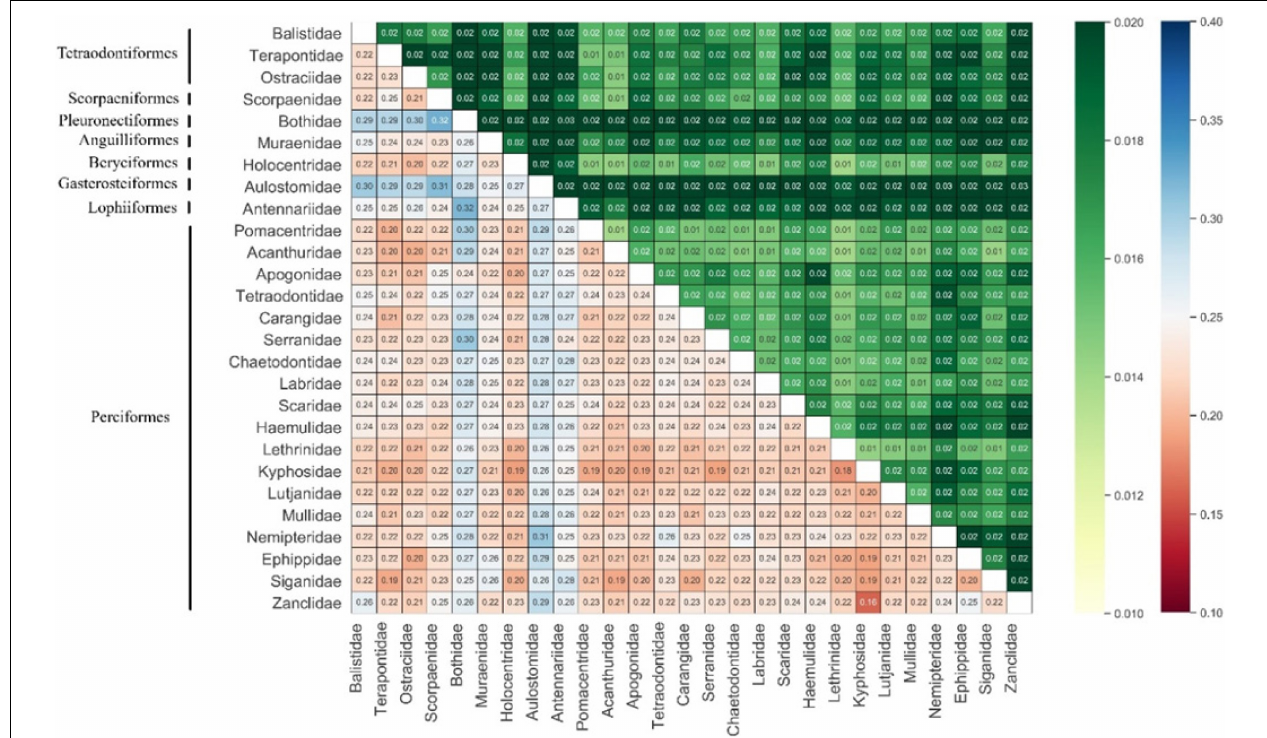
FIGURE 3 | Average K2P divergences between COI barcodes of